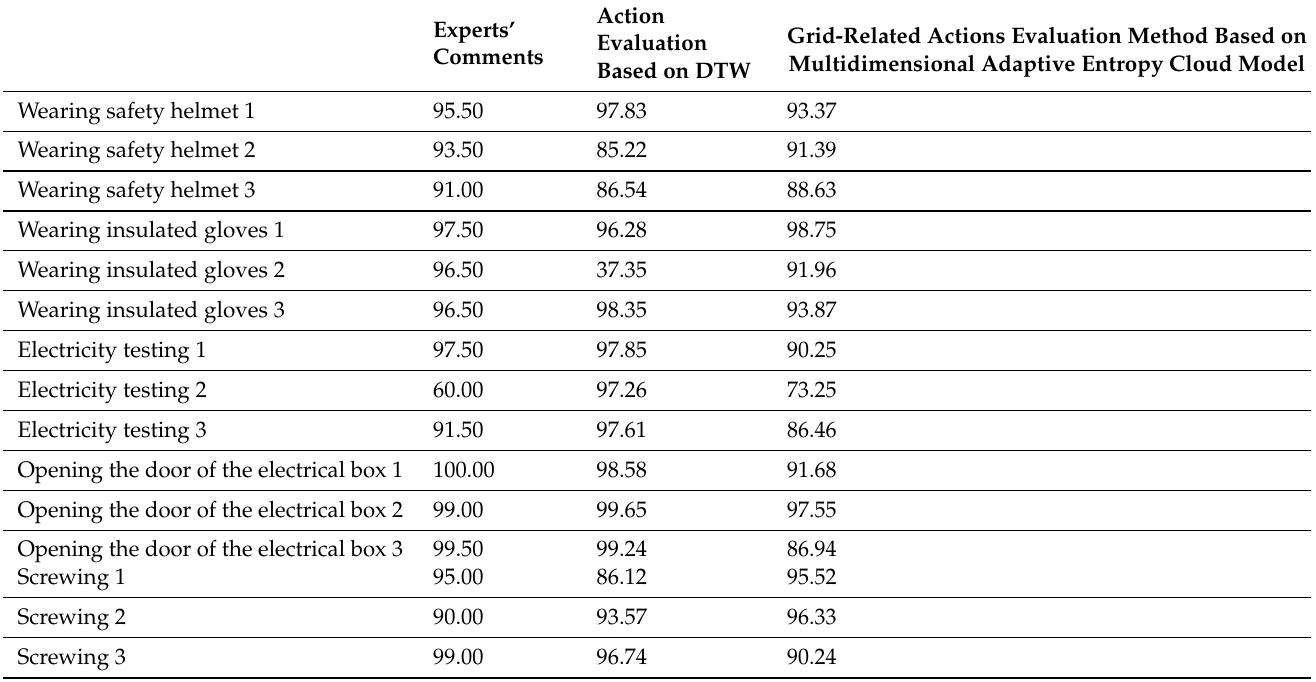
Table 2. Action distribution of multiscale hand data